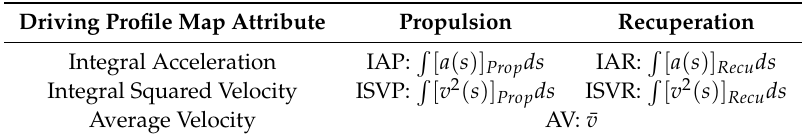
Table 1. Derived energetic driving profile map attributes (DPMAs), which generally describe the impact of the driving profile on a vehicle’s energy